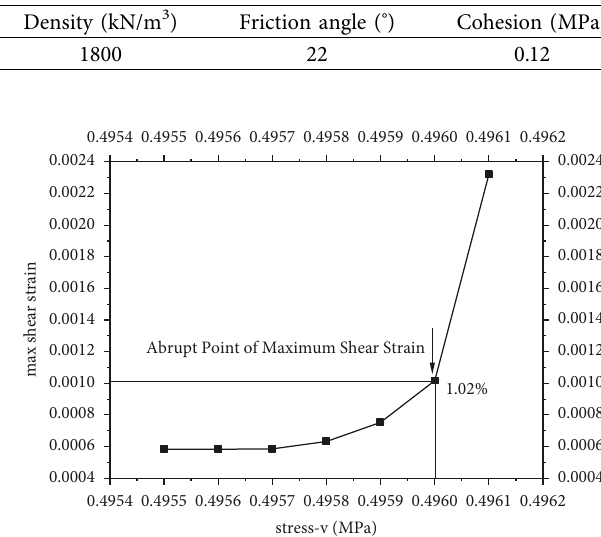
Table 1: Computational mechanics parameters.